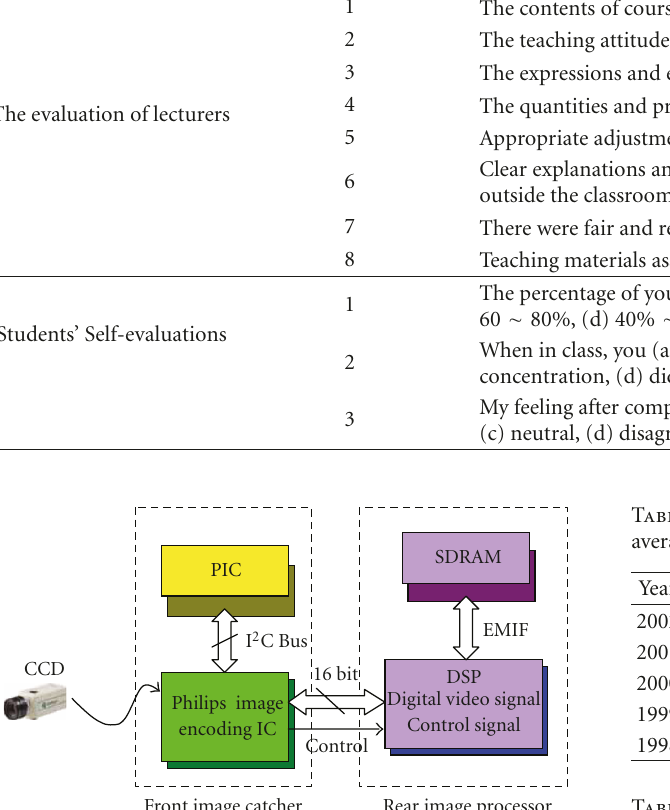
Table 3: Digital Signal Processors Fundamentals teaching feedback survey; the average marks for the first section.